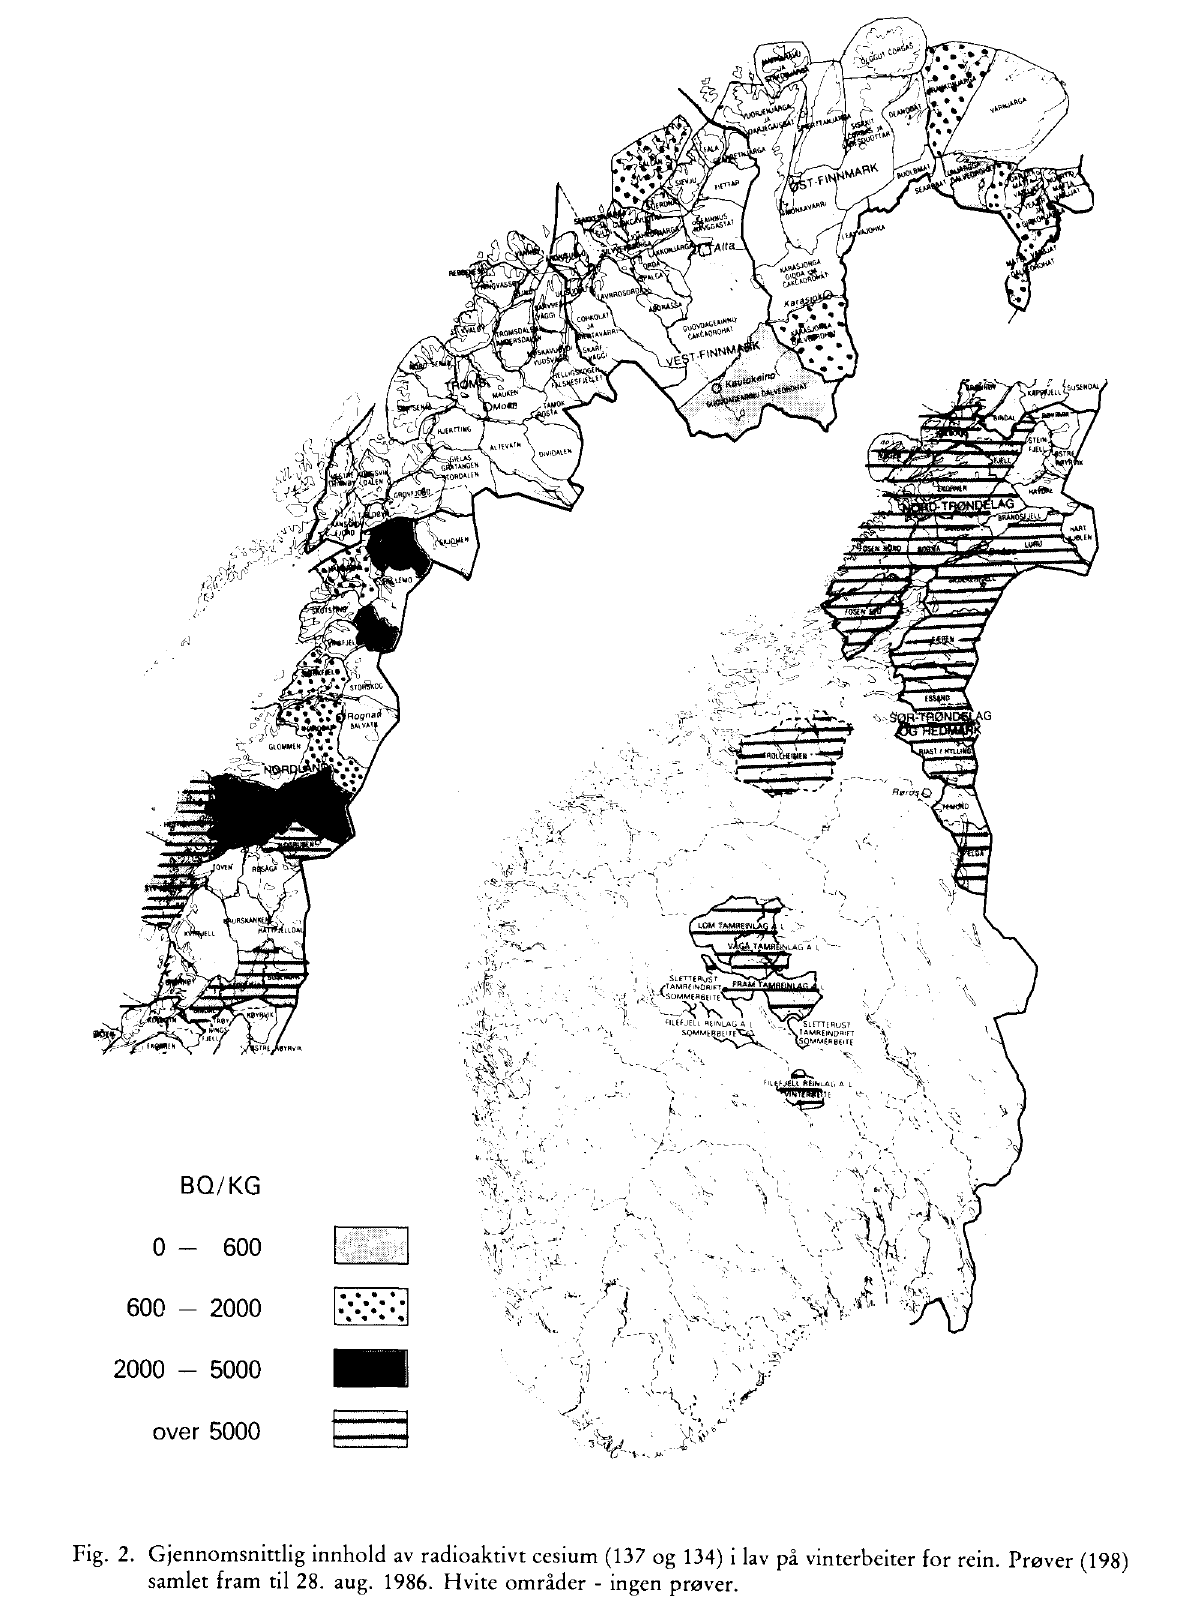
Fig. 2. Gjennomsnittlig innhold av radioaktivt cesium (137 og 134) i lav på vinterbeiter for rein. Prøver (198) samlet fram til 28. aug. 1986. Hvite områder - ingen prøver. Rangifer, 1986, No. 1.